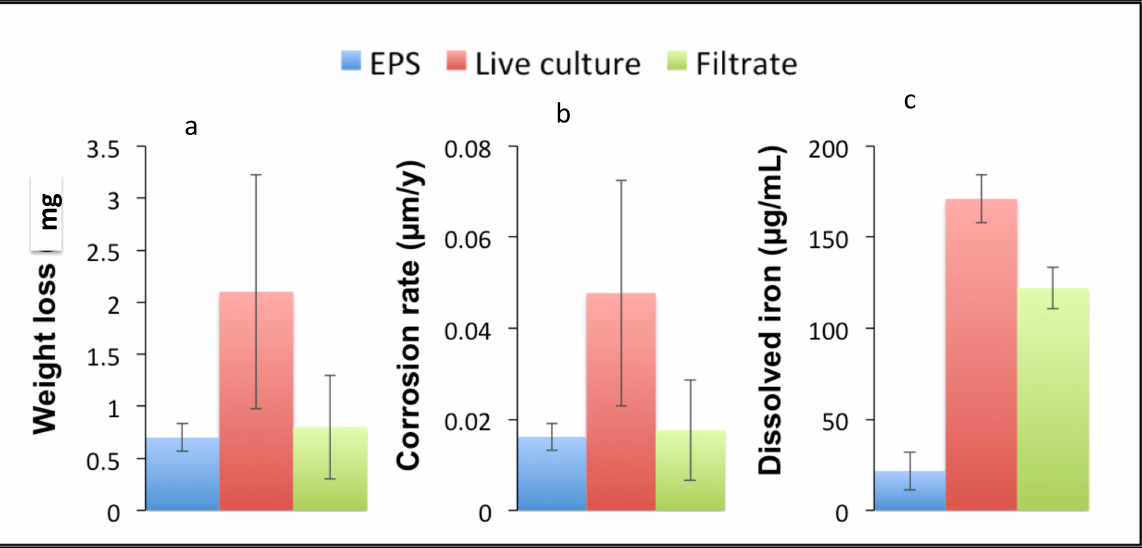
Figure 6. EPS corrosivity relative to the live cells and cultural fluid: ( a ) coupon weight loss; ( b ) corrosion rate based on the weight loss; ( c ) dissolved total